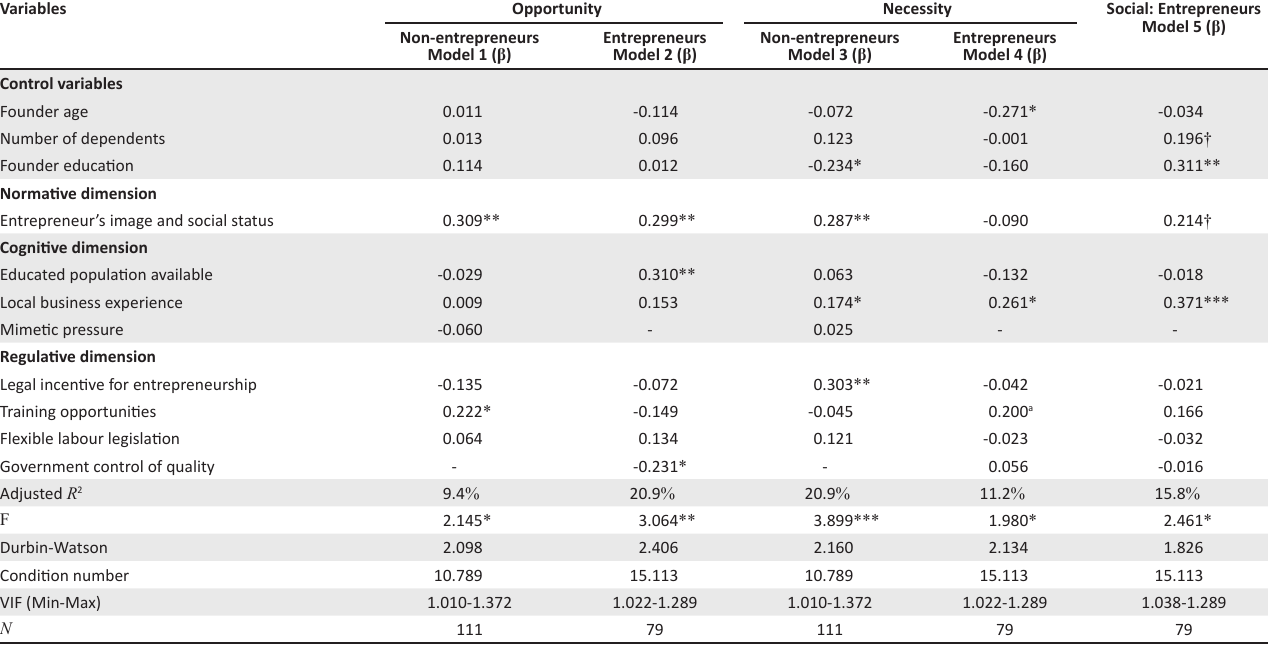
TABLE 4: Results of estimated models for components of entrepreneurial motivation: Entrepreneurs and non-entrepreneurs subsamples.